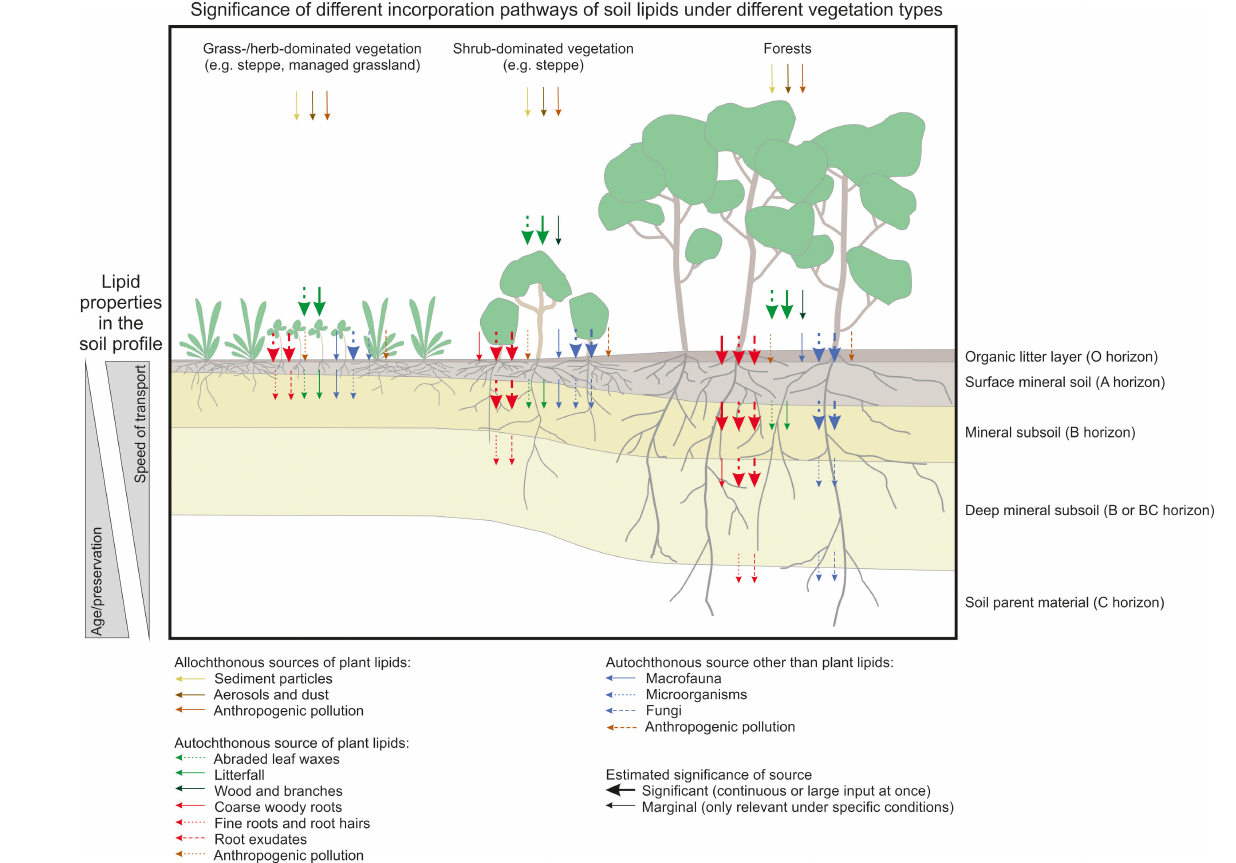
Figure 1. Conceptual overview of different incorporation pathways of lipids in soils originating from different biological sources and an- thropogenic contamination. The different sources are indicated by distinct colors and lines of the arrows. The line thickness is an estimated significance of individual sources without providing a quantitative measure for different sources. Autochthonous sources are further distin- guished by their significance in different soil depths or soil horizons. Further, the transport, age, and probability of preservation as general properties of lipids are given on the left side of the